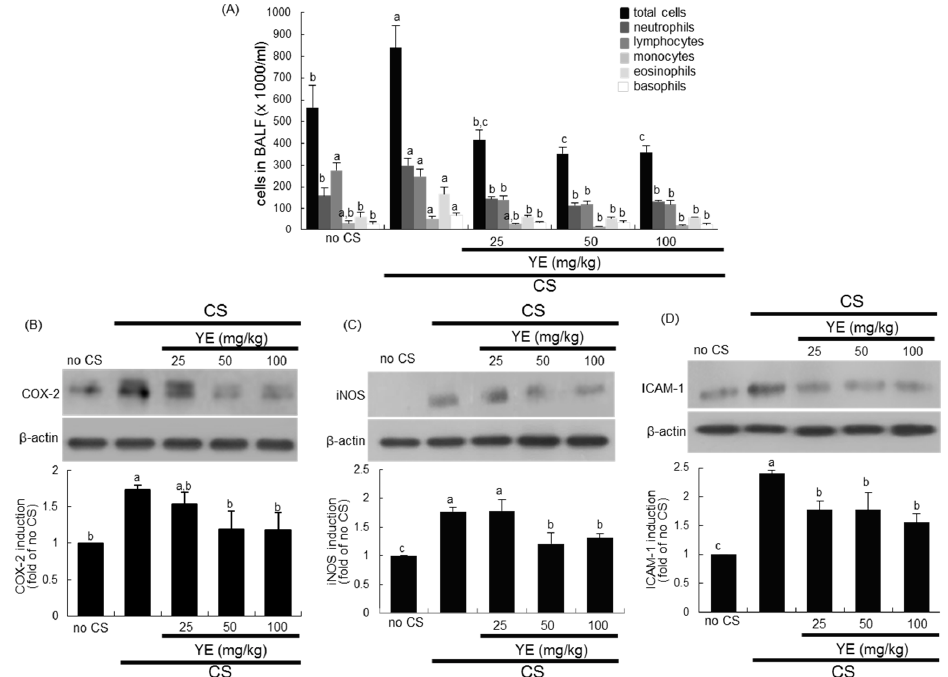
Figure 1. Leukocytes in the bronchoalveolar lavage fluid (BALF; A ) and inhibition of pulmonary inflammation ( B – D ) in cigarette smoke (CS)-challenged mouse lungs treated with dried yeast extracts (YE). Mice were orally administrated with 25–100 mg/kg YE and exposed to CS for 30 min. Cells in BALF were counted using a Hemavet HV950 Multispecies Hematologic Analyzer ( A ). Tissue extracts were subject to Western blot analysis with a primary antibody against COX-2, iNOS, or ICAM-1. β - Actin protein was used as an internal control. The bottom bar graphs represent quantitative results of the upper bands obtained from a densitometer. Values (mean ± SEM, n = 3–4) in respective bar graphs not sharing a same small letter indicate a significant difference at p <